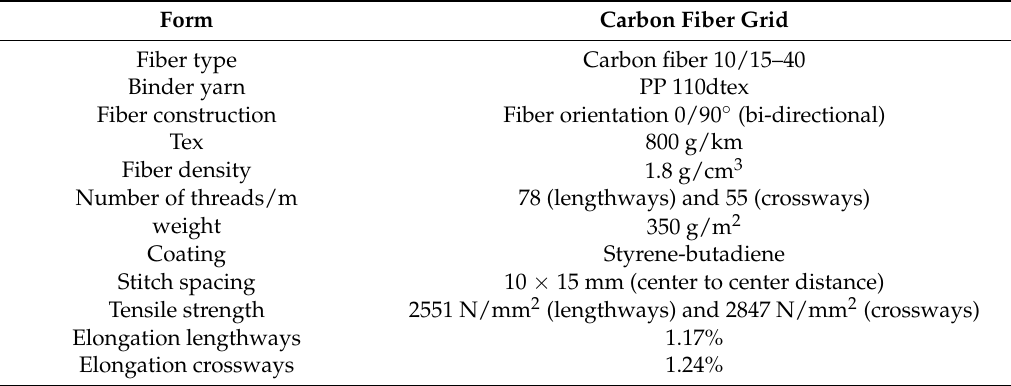
Table 1. Properties of carbon textile.